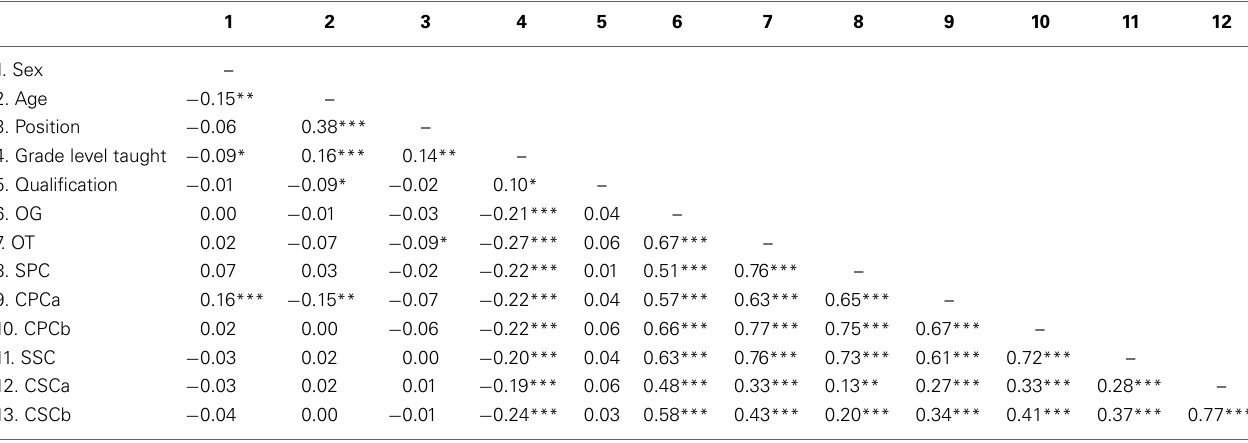
Table 3A | Bivariate correlations between the demographic variables and control processes.